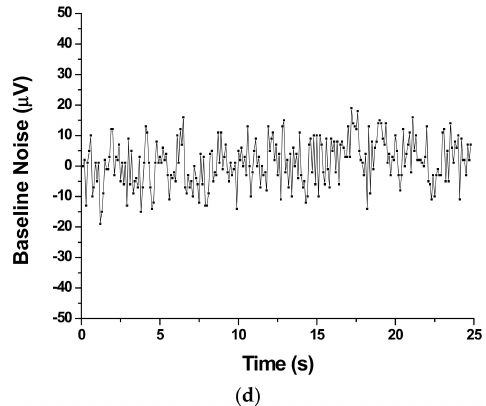
Figure 5. ( a ) The proposed SAW H 2 S sensor system. ( b ) The Printed Circuit Board (PCB) of the sensor system, ( c ) the gas chamber, and ( d ) measured baseline noise.